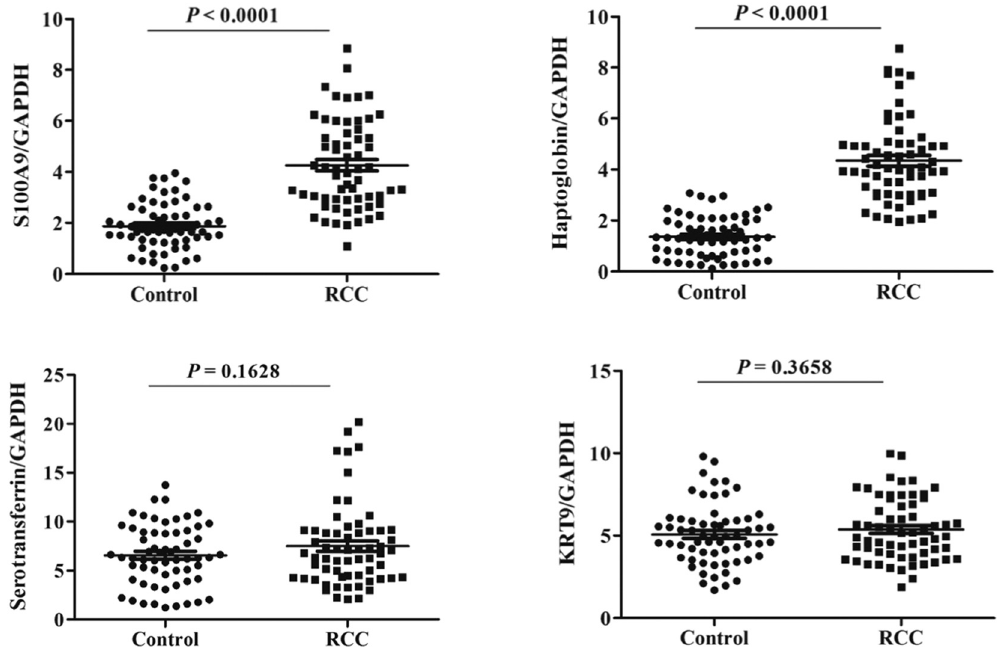
Figure 2: Discovery and veri fi cation of candidate salivary biomarkers. S100A9, haptoglobin, serotransferrin and KRT9 levels in the saliva of